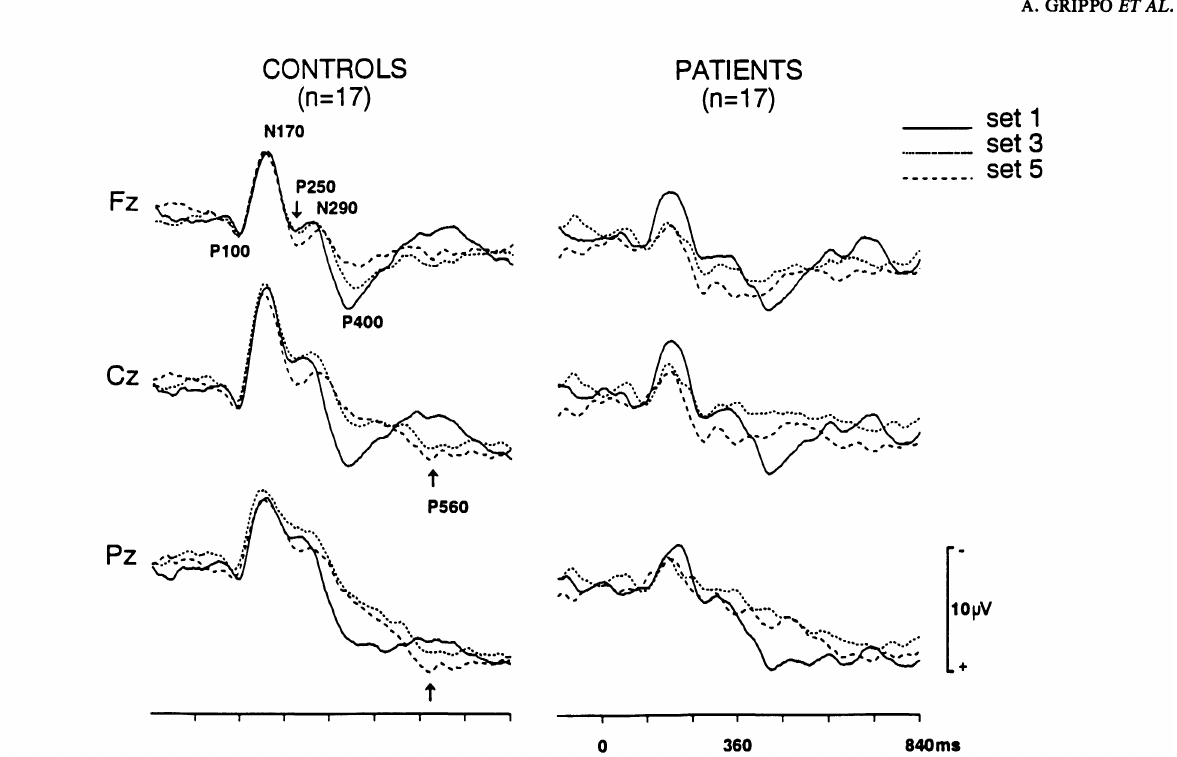
FIG. 2. Superimposition of group averages of positive probes of controls and patients by memory set size. The major components are labelled according to their polarities and approximate mean latencies. Note the changes with set size and topography in controls (left column): P400 reduces with increasing set size and a second positive wave (P560) appears in responses to larger sets, particularly at Cz and Pz. In the patients' responses, all components can be identified, but with increasing set size the N170 is reduced. In this and the following figure, probe presentation is at time zero and the time divisions and pre-stimulus epoch are 120